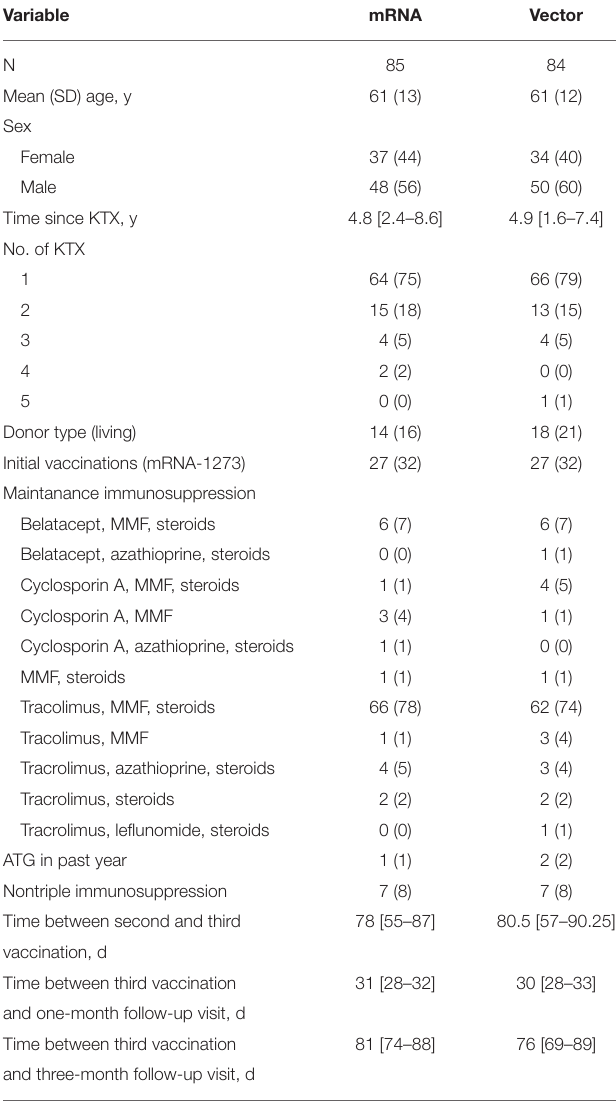
TABLE 1 | Demographics of the study population. Variable mRNA